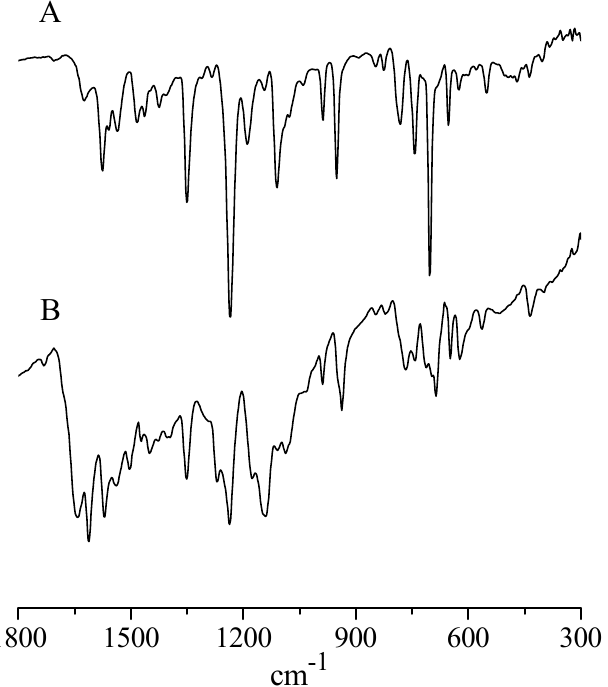
Figure 6. IR spectra of [Py 8 TPyzPzIn(OAc)] · 8H 2 O ( A ) and [(2-Mepy) 8 TPyzPzIn(OAc)](I) 8 · H 2 O ( B ) in the range 1800–300 cm − 1 .